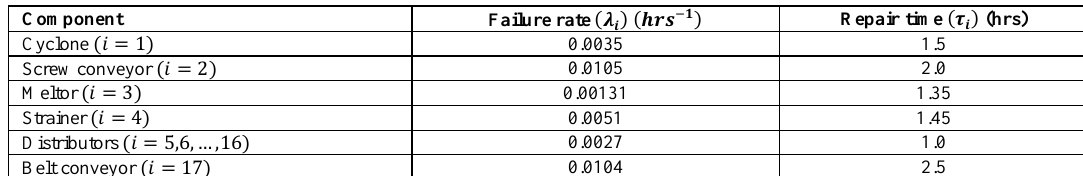
Table 1. Input data for prilling and carbon recovery unit.